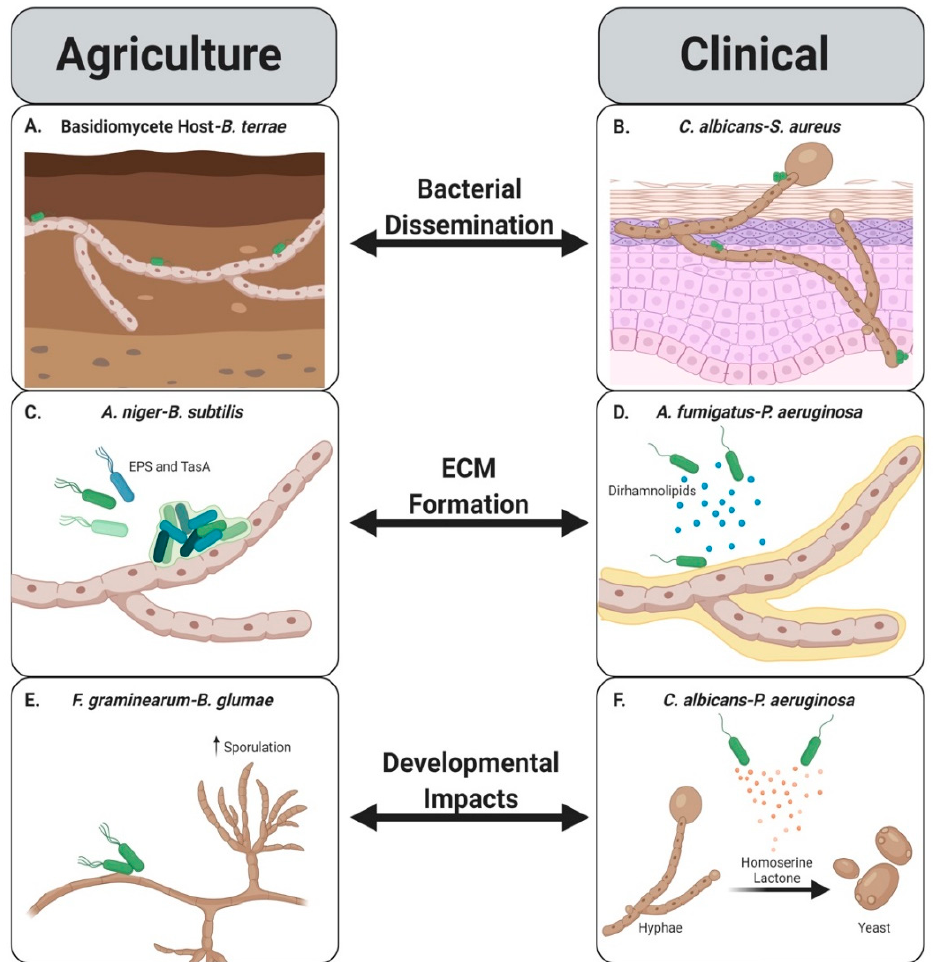
Figure 2. Common outcomes of BFIs in agriculture and clinical systems. Bacteria (green) travel along fungal hyphae (tan) ( A , B ) resulting in their dissemination. The ECM produced by bacteria (( C )—green, EPS and TasA) or induced ECM (yellow) by bacterial mediators (( D )—Blue, dirhamnolipids) mediates bacterial binding to the fungal organisms (tan) ( C , D ). Developmental changes occur in fungi (tan) upon interaction with bacteria (green) ( E , F ). Created with BioRender.com.